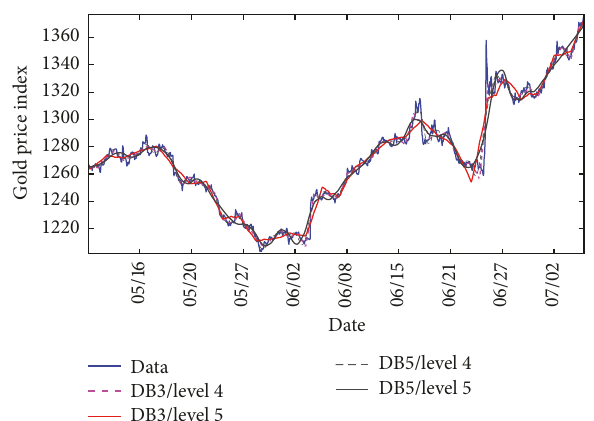
Figure 2: Return charts of XAU/USD.